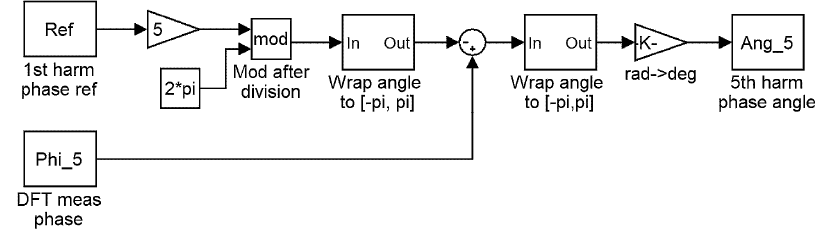
Figure 3. Voltage 5th harmonic phase angle calculation.